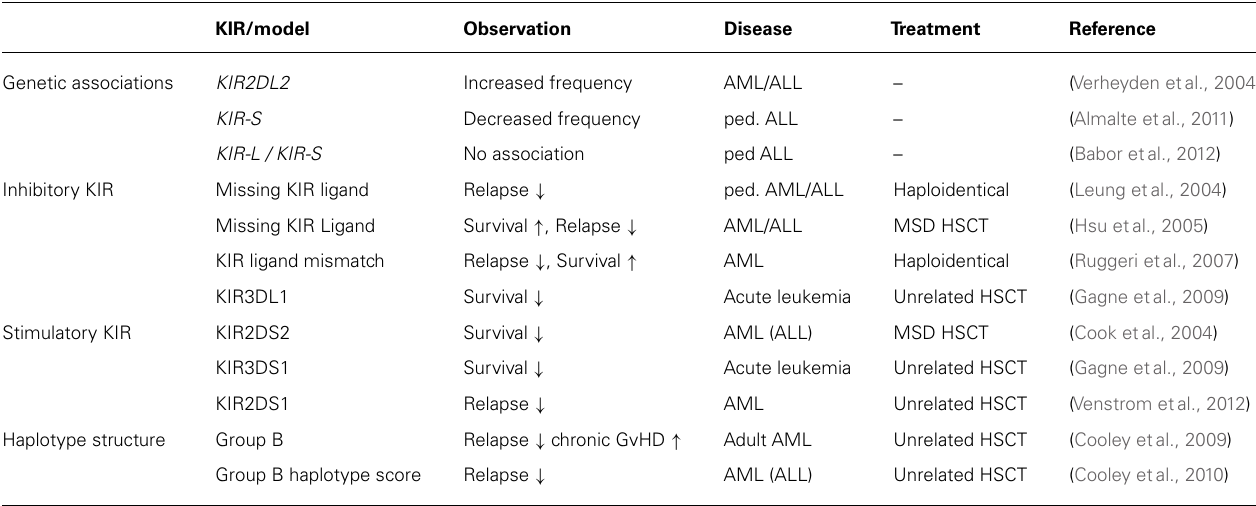
Table 2 |An overview of studies analyzing the role of KIR for susceptibility and clinical HSCT for